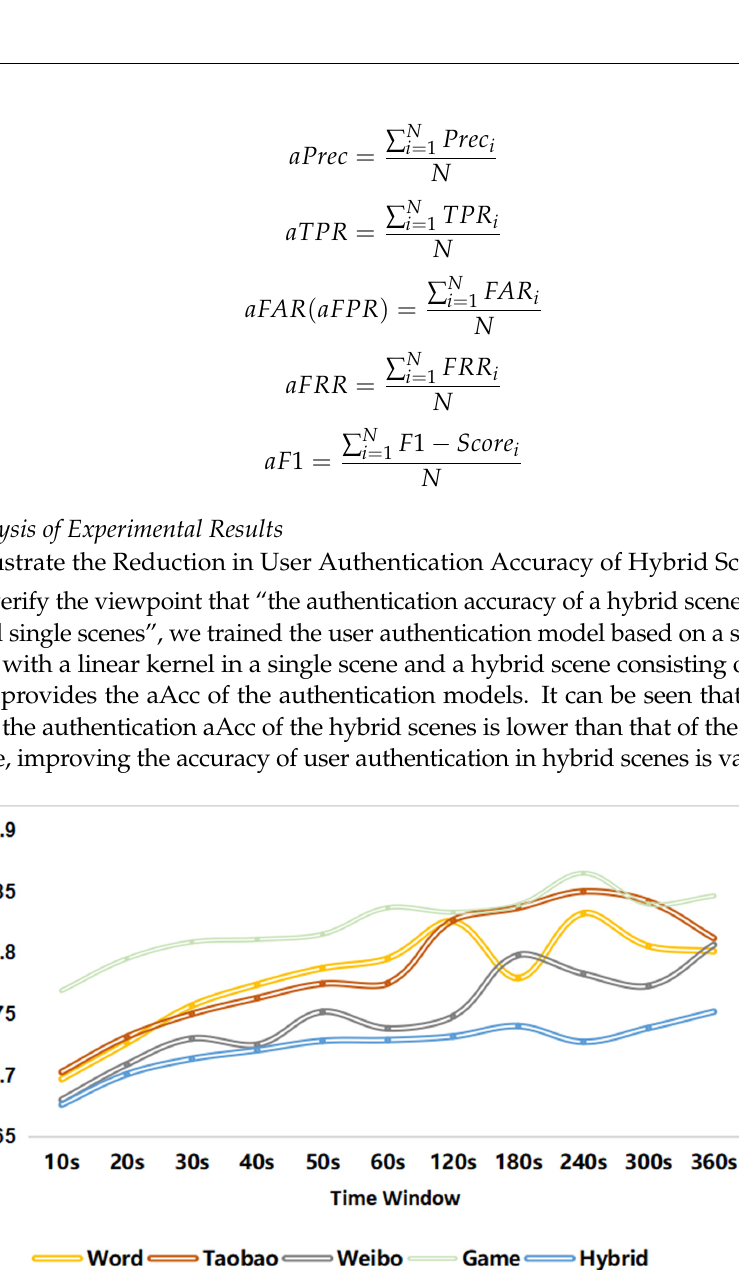
Figure 7. Accuracy of SIURUA in each feature combination.